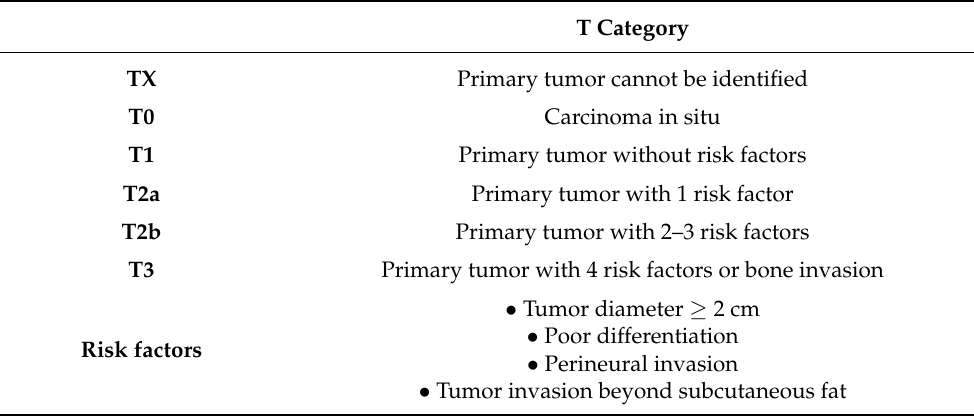
Table 6. T classification for cutaneous squamous cell carcinoma according to Brigham and Women’s Hospital staging